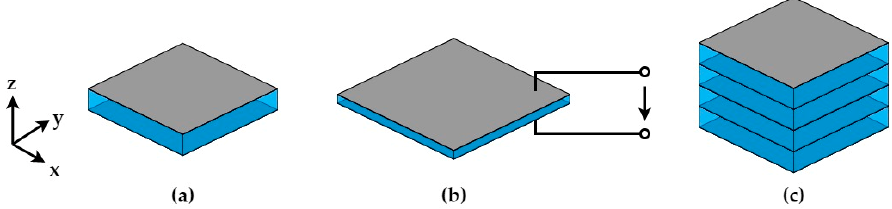
Figure 1. Dielectric elastomer actuator ( a ) not activated ( b ) activated ( c ) stacked. DEAs follow electrostatic principles. When an electric field is applied across the electrodes by a voltage, the charges move from one electrode to the other via an external con- ductor. As a result, the positive charges accumulate at one electrode and the negative charges at the other electrode, which leads to an electrostatic force of a tt raction between the two electrodes. This force is also known as the Coulomb force and compresses the dielectric elastomer (DE) membrane. The compression creates a stress inside the DE